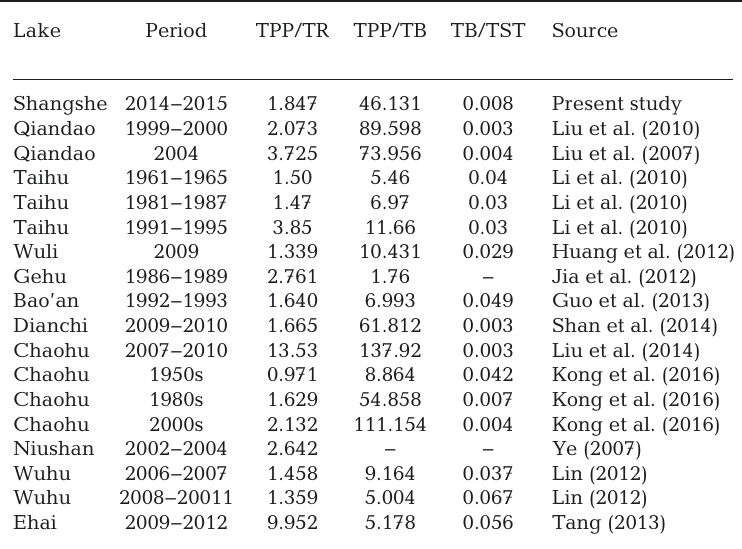
Table 8. Ecosystem properties of lake ecosystems in China. TPP: total pri - mary production; TR: total respiration; TB: total biomass; TST: total through- put. –: no